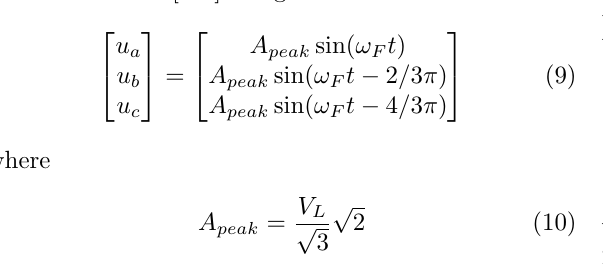
of the VCC is shown in Fig. 10.